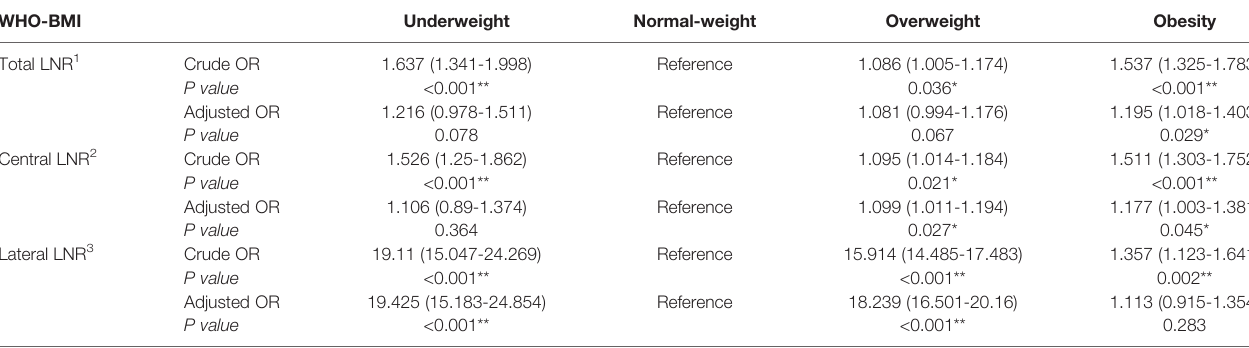
TABLE 7 | Binary logistic regression analyzed the relationship between BMI and the risk of